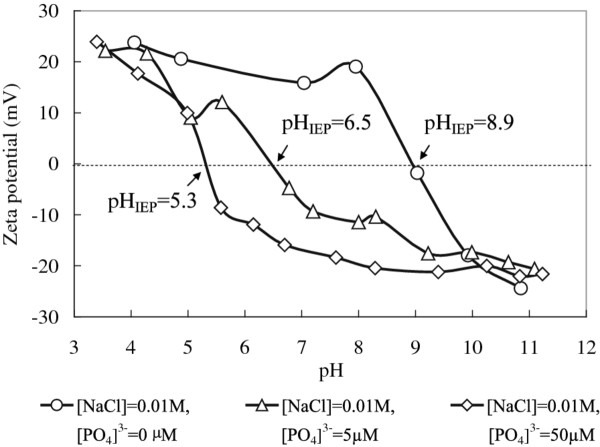
Zeta potential of mesoporousγ-Al2O3in the absence and presence of phosphates. Phosphate concentrations and pH values are indicated.